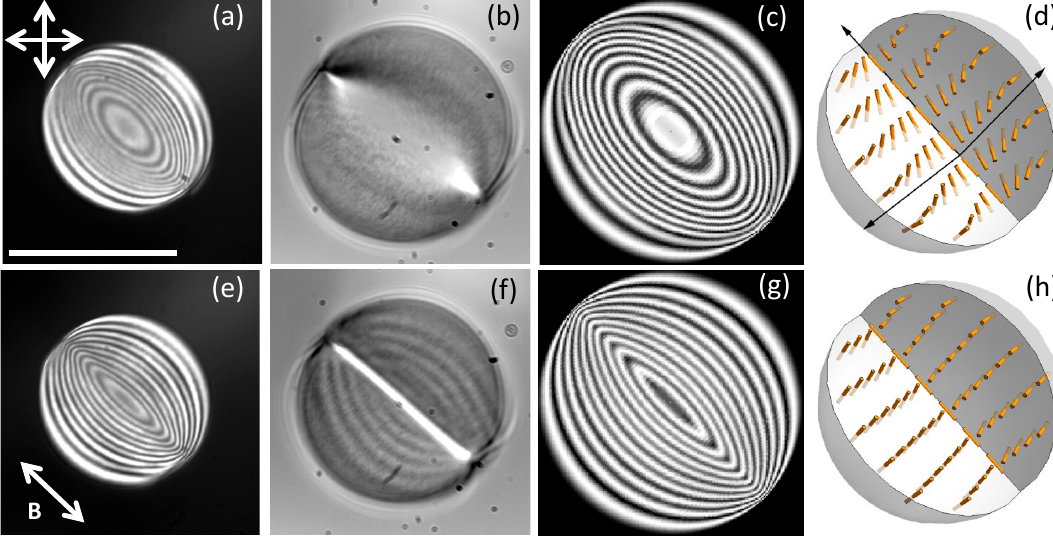
B Figure 2. SSY nematic gem in coexistence with its isotropic phase, in the absence ( a – d ) and in the presence ( e – g ) of a 0.4 T in-plane uniform magnetic field, as indicated in panel ( e ) (see also Movie 1 and Movie 2 for textural changes during the ramping up of the magnetic field). Optical micrographs with crossed polarizers ( a , e ) and without polarizer ( b , f ) are shown. Simulated textures corresponding to ( a ) and ( e ) are shown in ( c ) and ( g ), respectively, obtained by computing the transmittance between crossed polarizers of the director field configurations sketched in ( d , h ). Scale bar is 100 µ